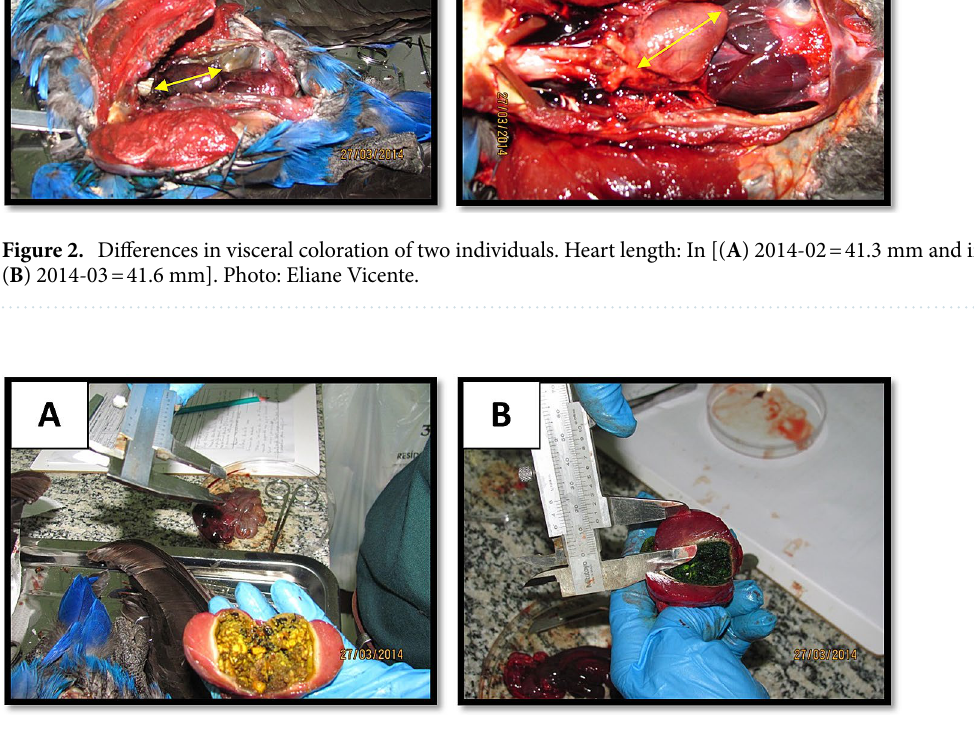
Figure 3. The gizzard specimens [( A ) 2014-02 and ( B ) 2014-03]. Photo: Carlos Cézar